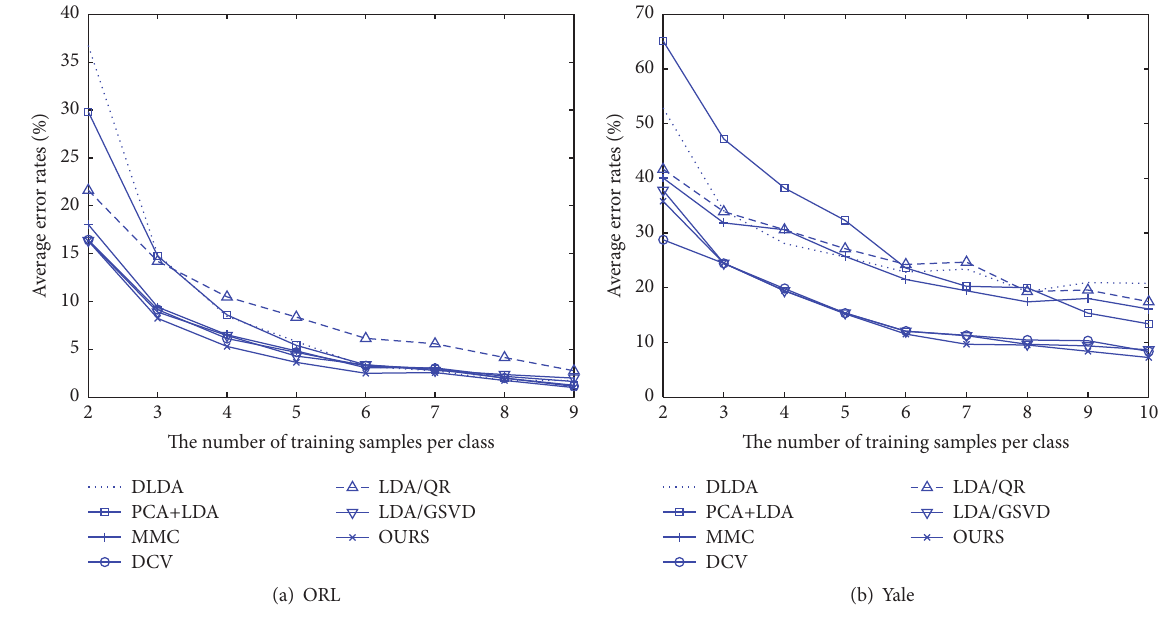
Figure 1: The error rates of each algorithm on two face databases.